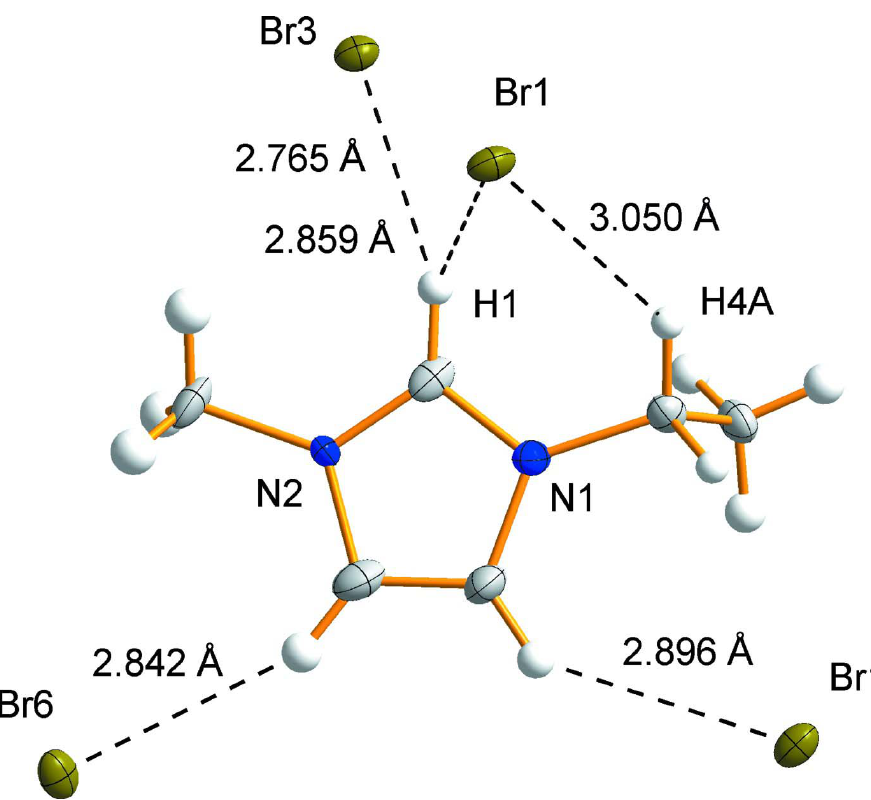
Figure 2 Surrounding of an [EMIM] + cation in the crystal structure of [EMIM] bonding interactions. Displacement ellipsoids are shown at the 50% probability level and H-atoms are drawn as small circles of arbitrary